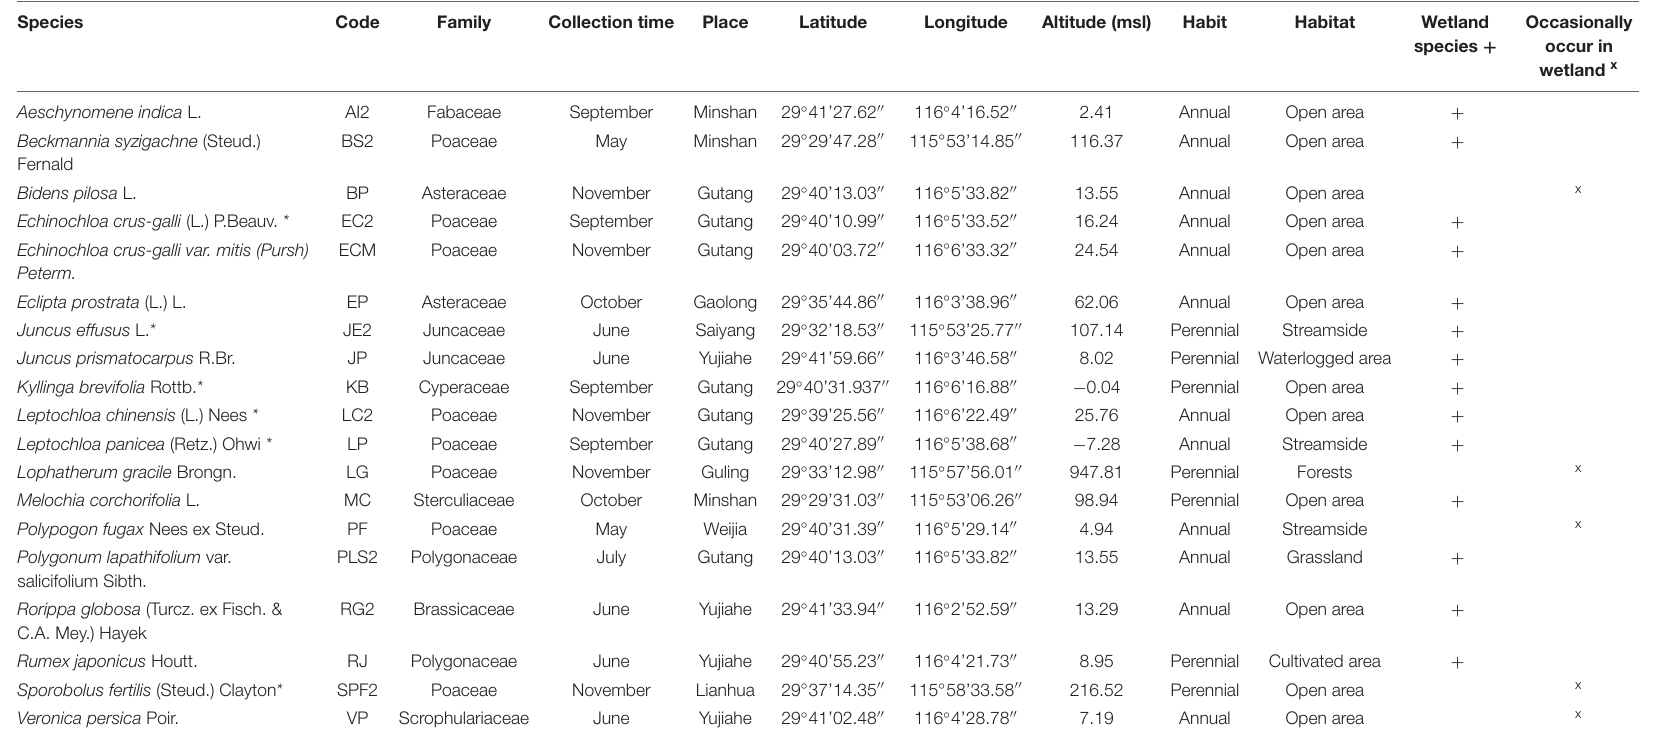
TABLE 1 | Location and other details of species.